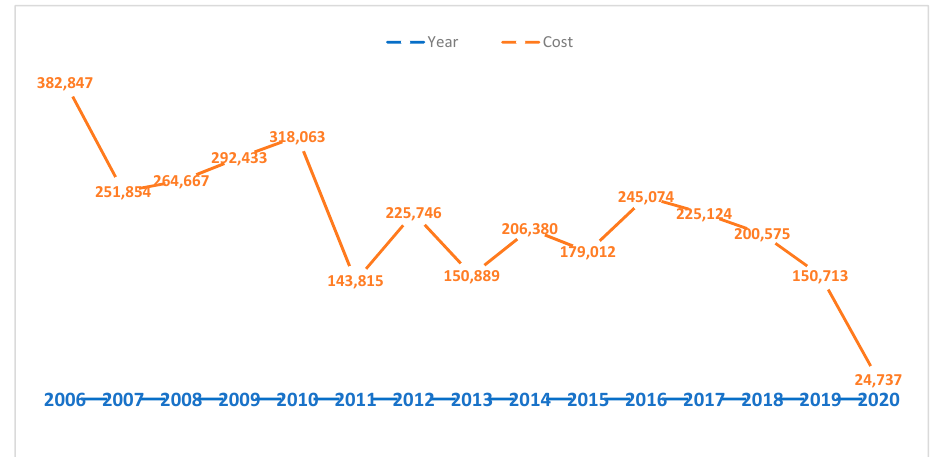
Figure 1. Economical trend related to varicella hospitalization cost ( EUR ).